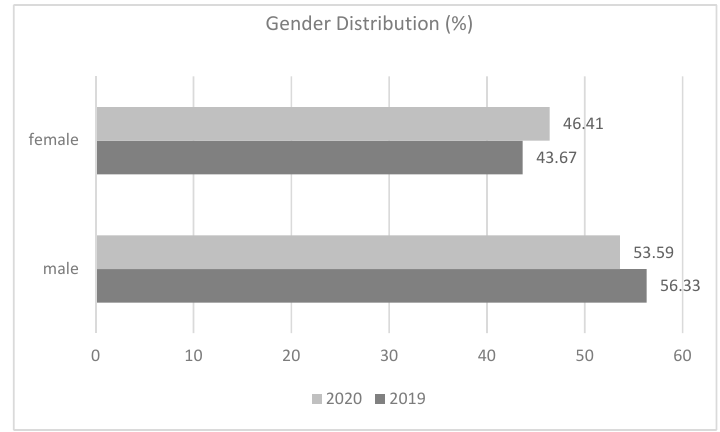
Figure 1. Differences in gender distribution in April 2019 compared to 2020. Figure 1. Di ff erences in gender distribution in April 2019 compared to